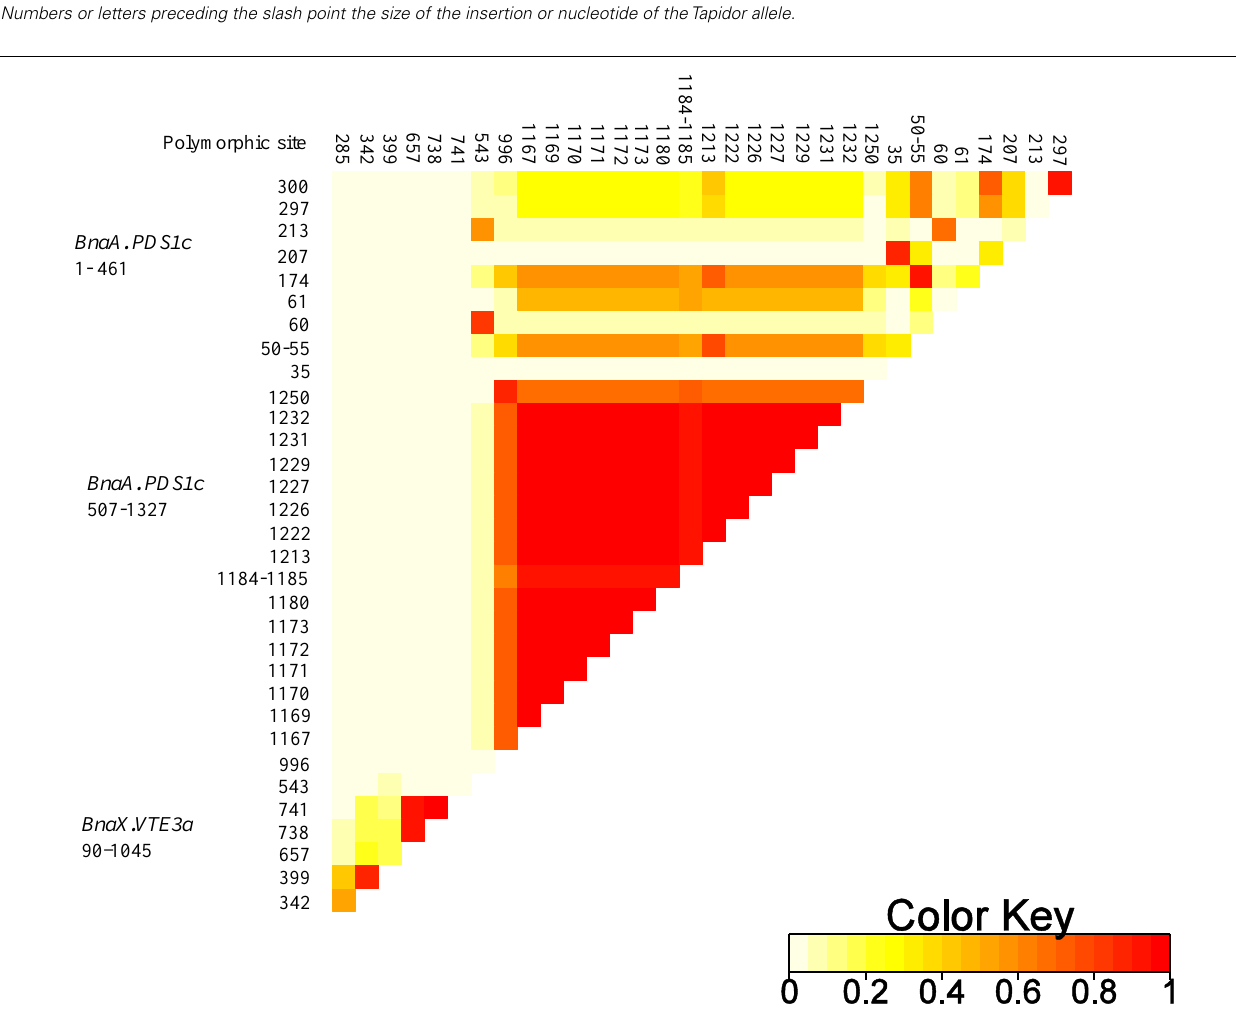
FIGURE 2 | Linkage disequilibrium (measured as r 2 ) between all pairs of SNP loci for three tocopherol candidate genes within the 96 accession dataset (plant panel 1). The color key shows the extent of linkage